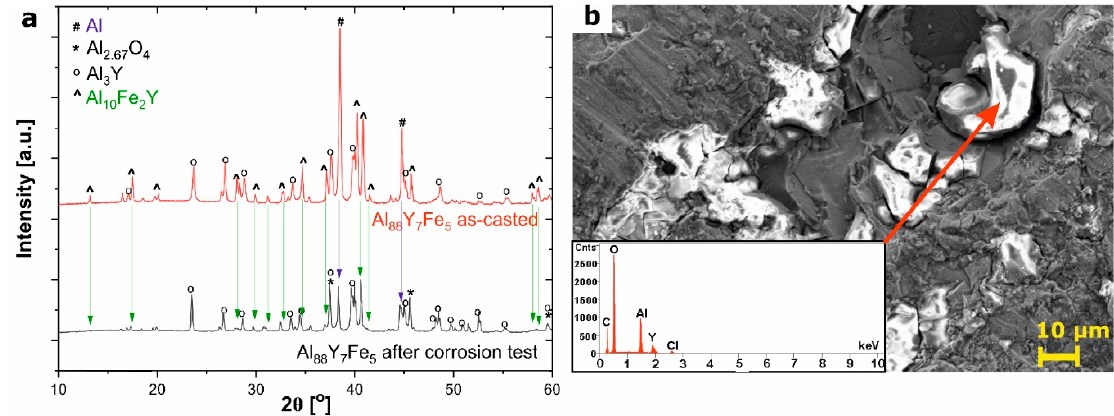
Figure 8. Analysis of the formation process of corrosion products on the surface of Al 88 Y 7 Fe 5 alloy: ( a ) comparison of XRD patterns of alloy before and after corrosion test with marked identified phases, ( b ) scanning electron microscopy (SEM) micrograph of Al 88 Y 7 Fe 5 surface after corrosion test (inset shows the energy-dispersive X-ray (EDX) spectrum).